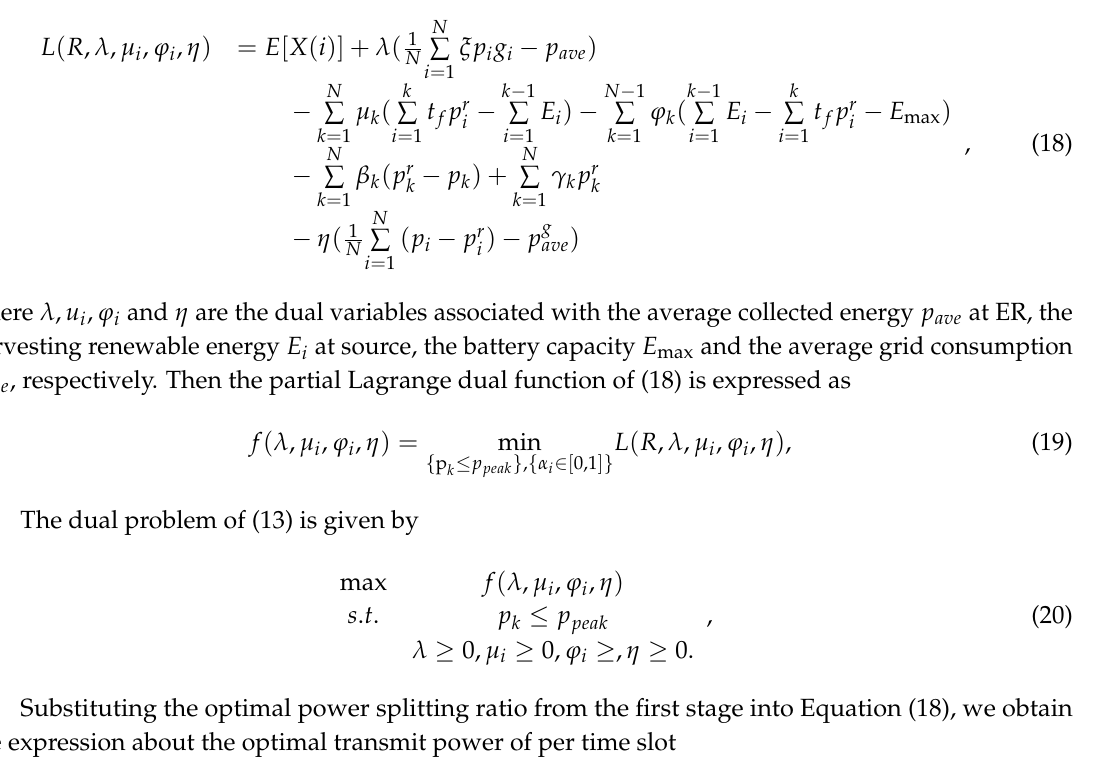
Figure 3. The optimal distribution of α i with σ 2